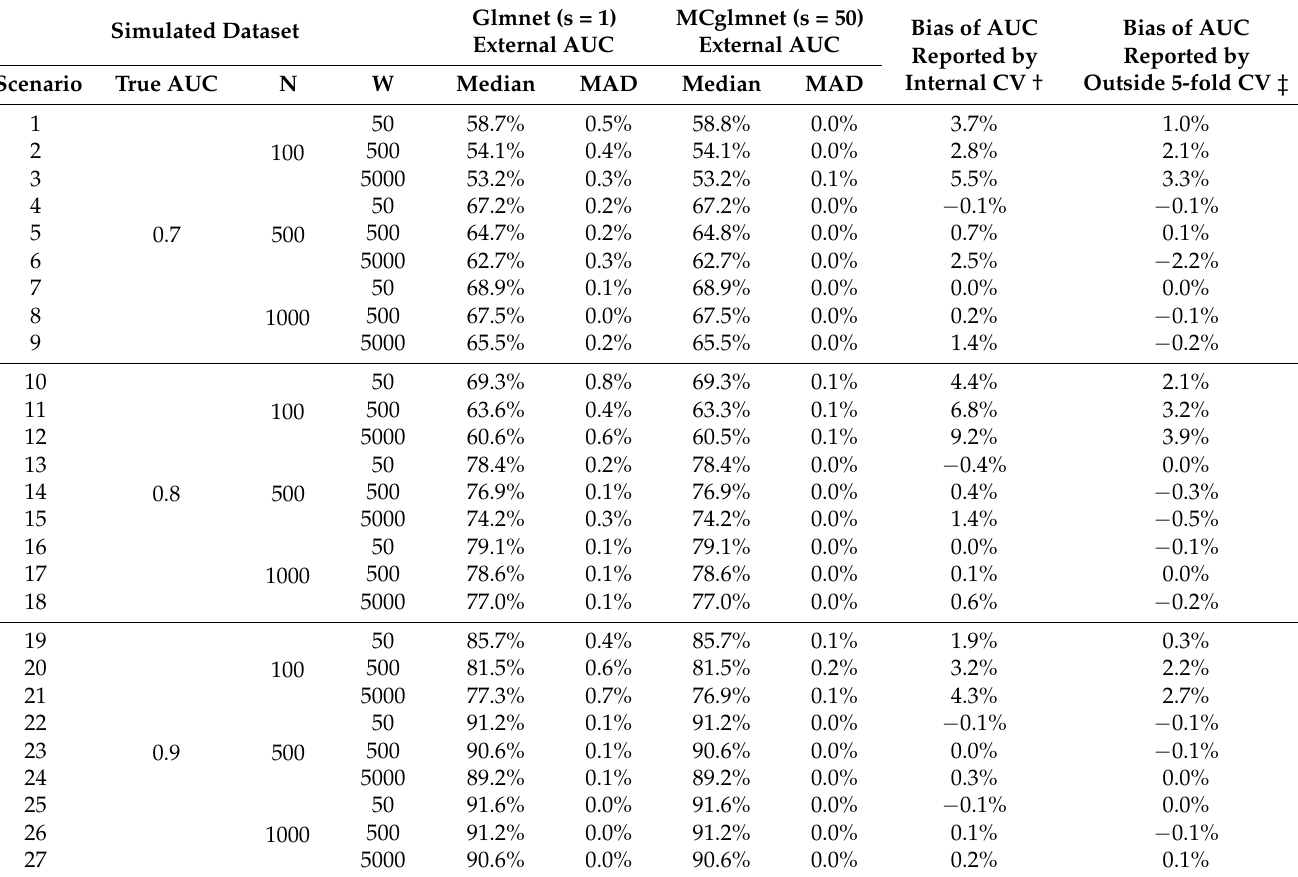
Table 1. Summary of external AUC from 100 replicated runs of each method and the bias of AUC reported by internal CV and the outside 5-fold CV wrapper. For MCglmnet, s =